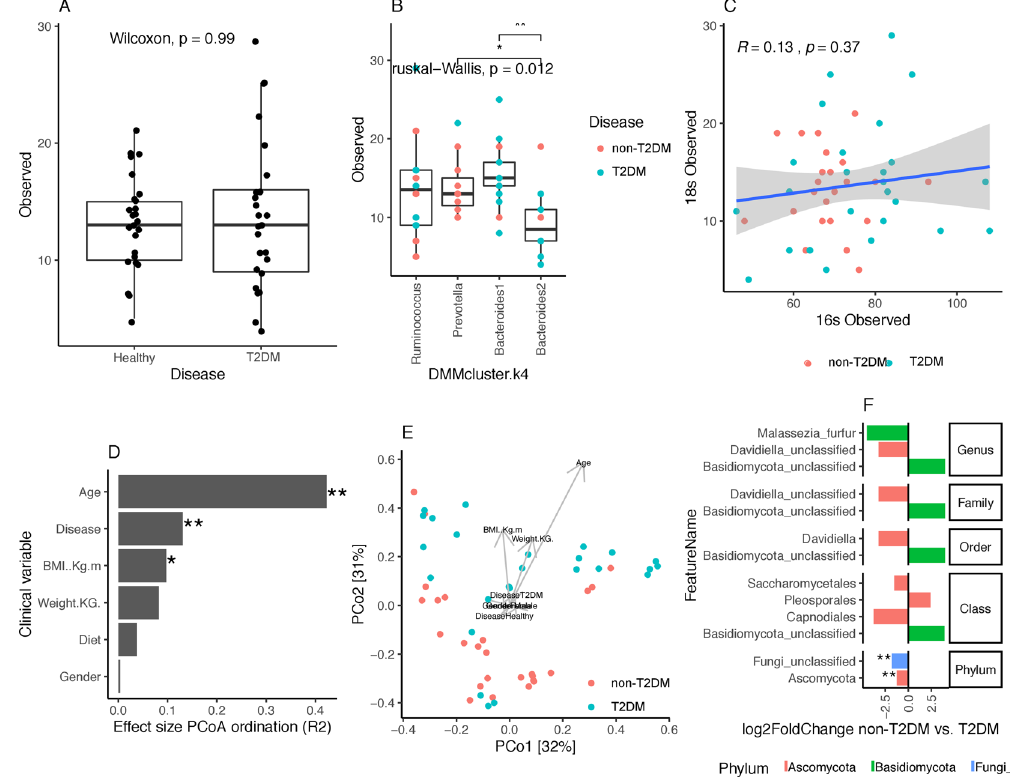
Figure 2. Fungal profiling of gut microbiome. ( A ) Alpha diversity distributions (observed species) between non-T2DM and T2DM groups. ( B ) Fungal diversity distributions (observed species) across DMM enterotypes ( ** = P value < 0.001; * = P value < 0.05; Wilcoxon rank-sum test). ( C ) Correlation between fungal and prokaryotic diversity (observed species). R and p corresponds to Spearman Rho and p-value of Spearman correlation test. ( D ) Effect sizes of environmental fitting of clinical variables and disease state over Principal coordinates ordination from panel E ( ** = P value < 0.05; * = P value < 0.1; permutation test). ( E ) Principal coordinates analyses of inter-individual differences (genus-level Bray-Curtis beta-diversity) with samples colored by disease state (non-T2DM, T2DM). Arrows represents effect sizes of the significant variables identified by environmental fitting analyses of panel D. ( F ) Bar plot of log2 fold changes in taxonomic feature abundance between non-T2DM controls and T2DM (P value < 0.05 in GLM model with negative binomial distribution of feature abundance by disease state adjusted by